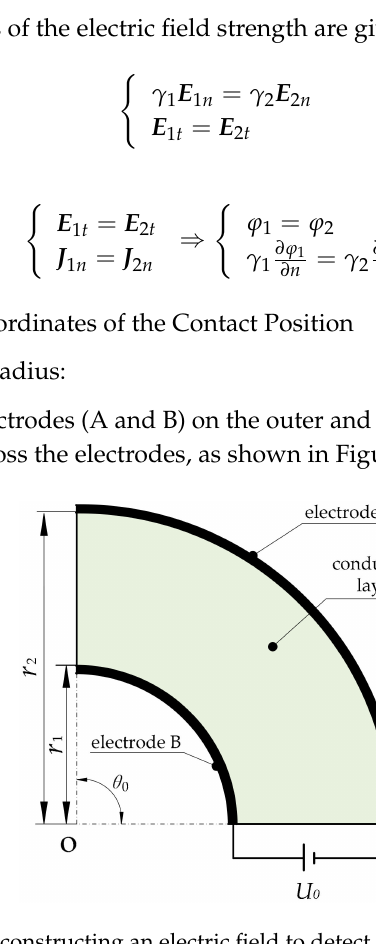
Figure 3. Method of constructing an electric field to detect the polar radius